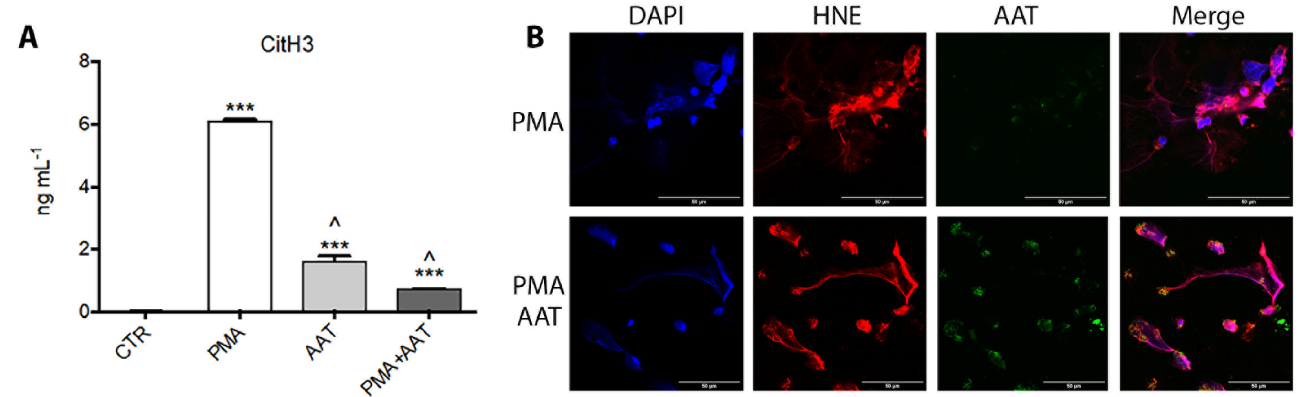
Figure 4. Panel ( A ). Quantification of CitH3 in neutrophils activated towards NETosis using PMA (100 nM) with or without AAT (500 µ g/mL) by ELISA assay after 4 h of incubation. Data are represented as mean of three independent replicates ± standard deviation. *** p < 0.01 vs. CTR; ^ p < 0.01 vs. PMA. Panel ( B ). Confocal microscopy images of neutrophils activated towards NETosis with PMA adding fluorescent AAT (green). DNA was labeled with DAPI and HNE with specific antibody (red). Scale bar = 50 µ m.